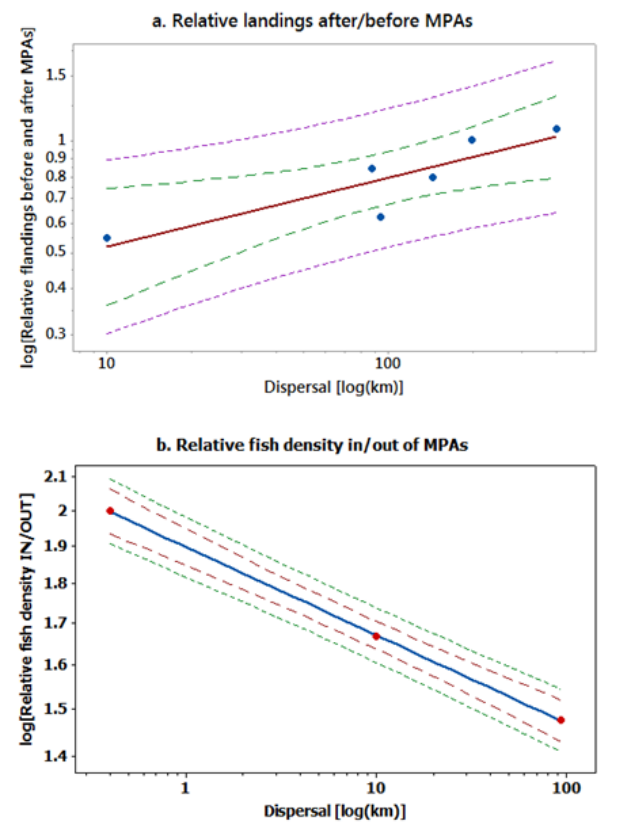
Figure 3. (a) Data of landings of five commercial fish species post- MPA establishment (Karpov et al., 2012), normalized by the land- ings of the same species pre-MPA establishment. The ratio of post- /pre-MPA establishment landings was regressed against the dis- persal range of each species. (b) Data of relative fish density in- side/outside the MPAs. The ratio of in/out MPA relative fish density was regressed against the dispersal range of each species (see sec- tion “Confronting model outputs with data” for more details). Solid lines are the best fit regression, dashed lines the 95% confidence interval, and dotted lines the 95% predicted